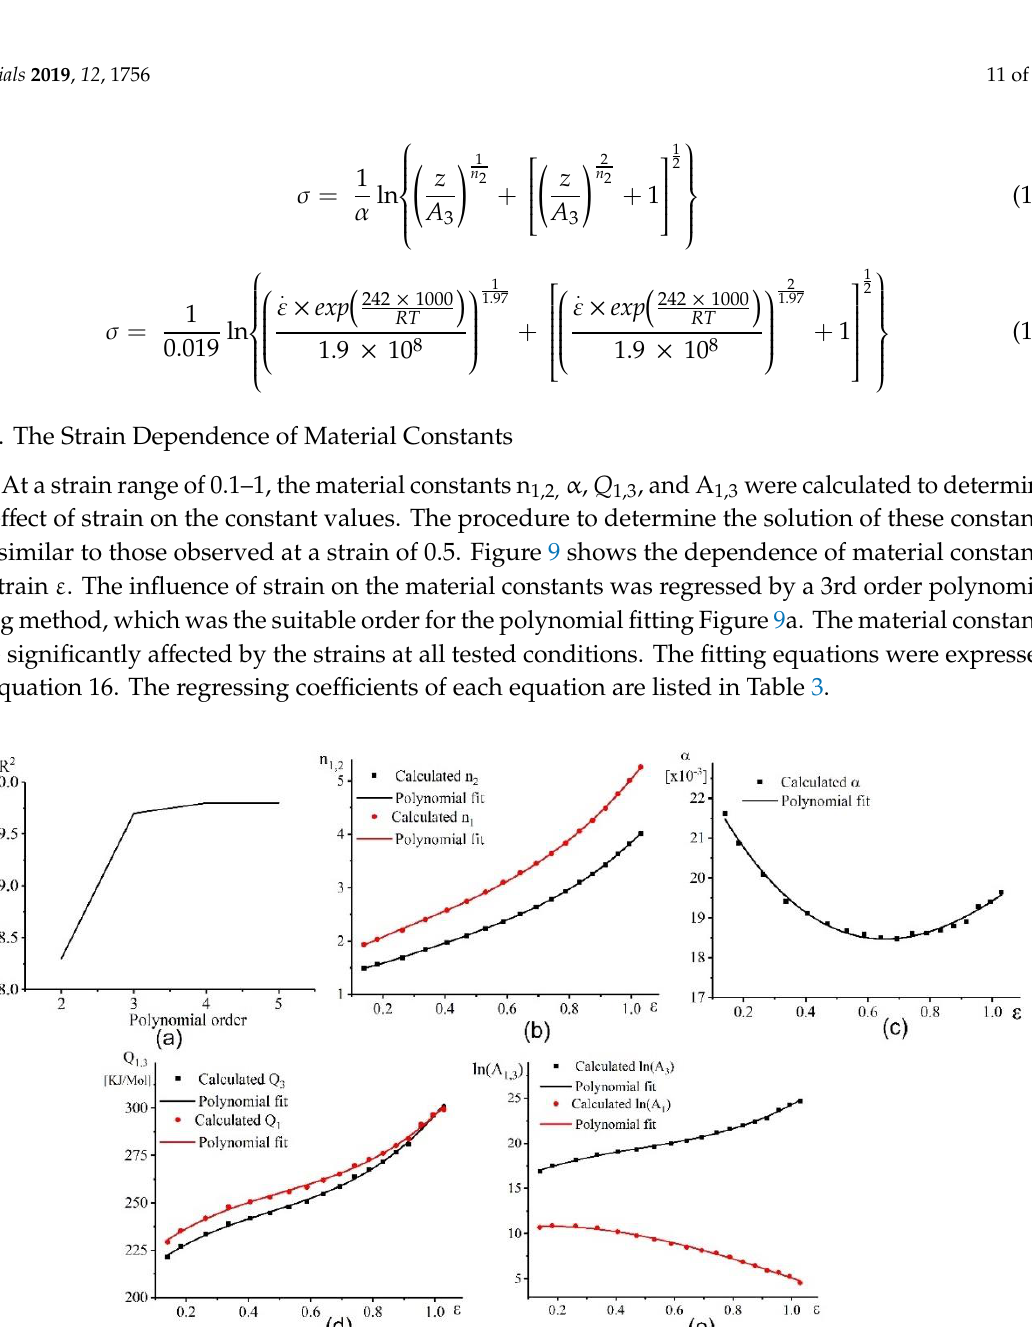
and the R 2 for this fitting. 3